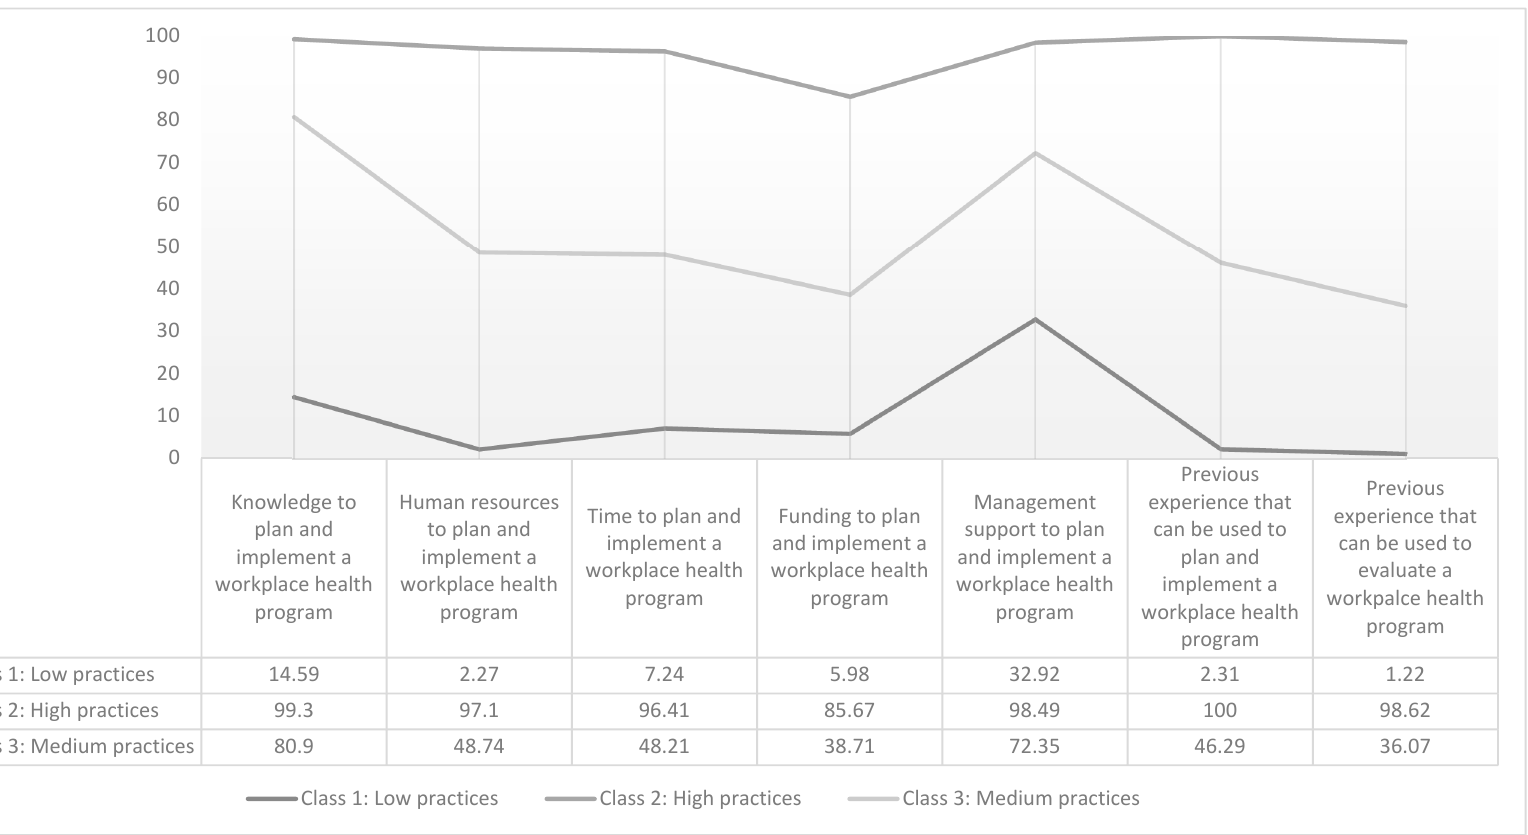
ffi rmative Response to Seven WHP Practices Items ( n =